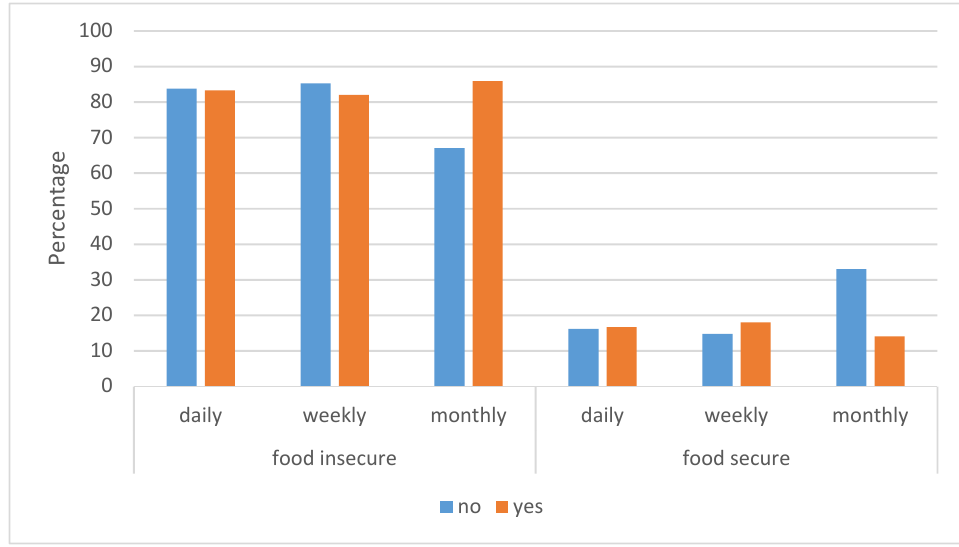
Figure 3. Clustered bar chart of food insecurity and food purchase frequency.